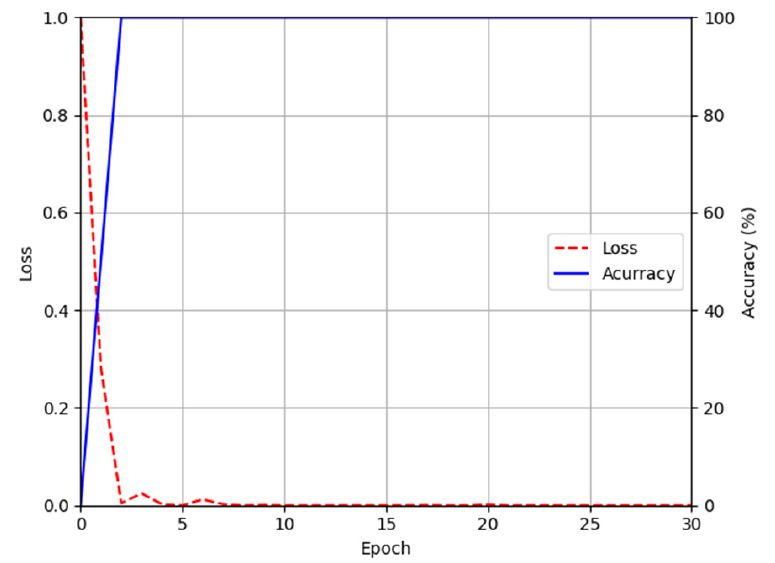
Figure 13. Training accuracy and loss graphs of DenseNet-161 using images restored by proposed modified DeblurGAN (SDU-DB).